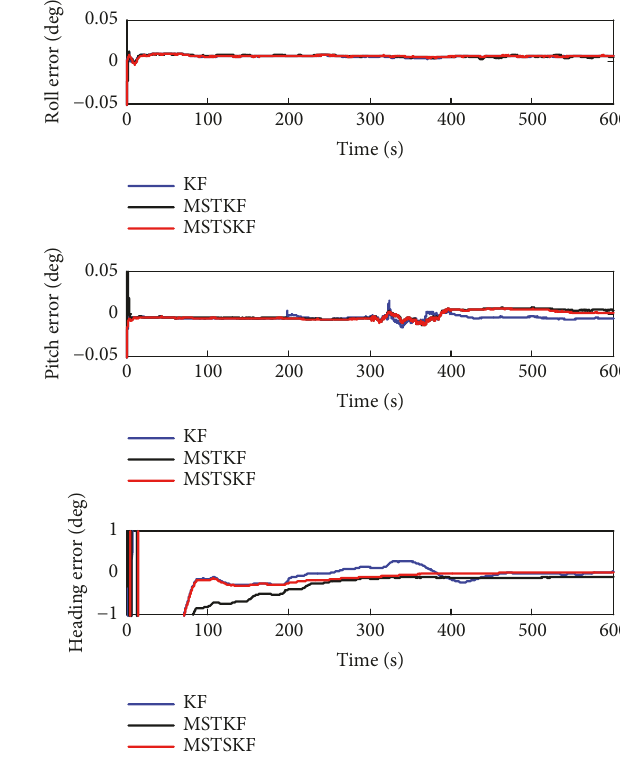
Figure 6: Attitude angle error of the experiment when the initial misalignment angles are large angles.